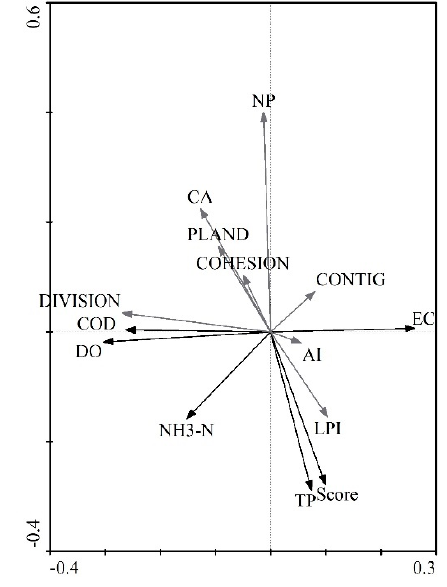
Figure 7. RDA ordination of landscape indices and surface water quality indicators.